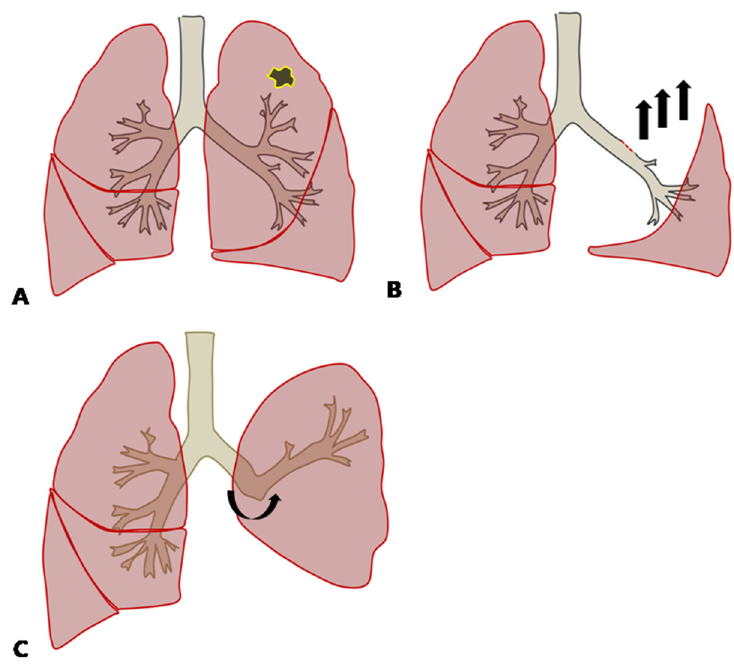
Figure 2. ( A ) In cases with lung cancer in the left upper lobe, left upper lobectomy (LUL) might be performed. ( B ) During LUL, the inferior pulmonary ligament is dissected, which induces the remaining left lower lobe to expand and move upward. ( C ) The remaining left lower bronchus is angulated upward after LUL.